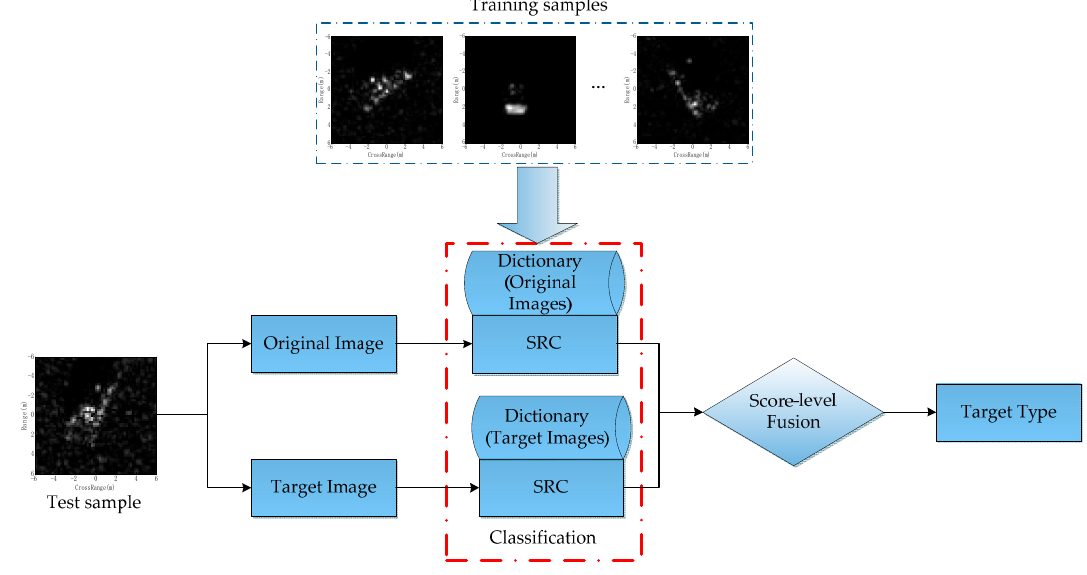
Figure 5. Illustration of the proposed target recognition method.